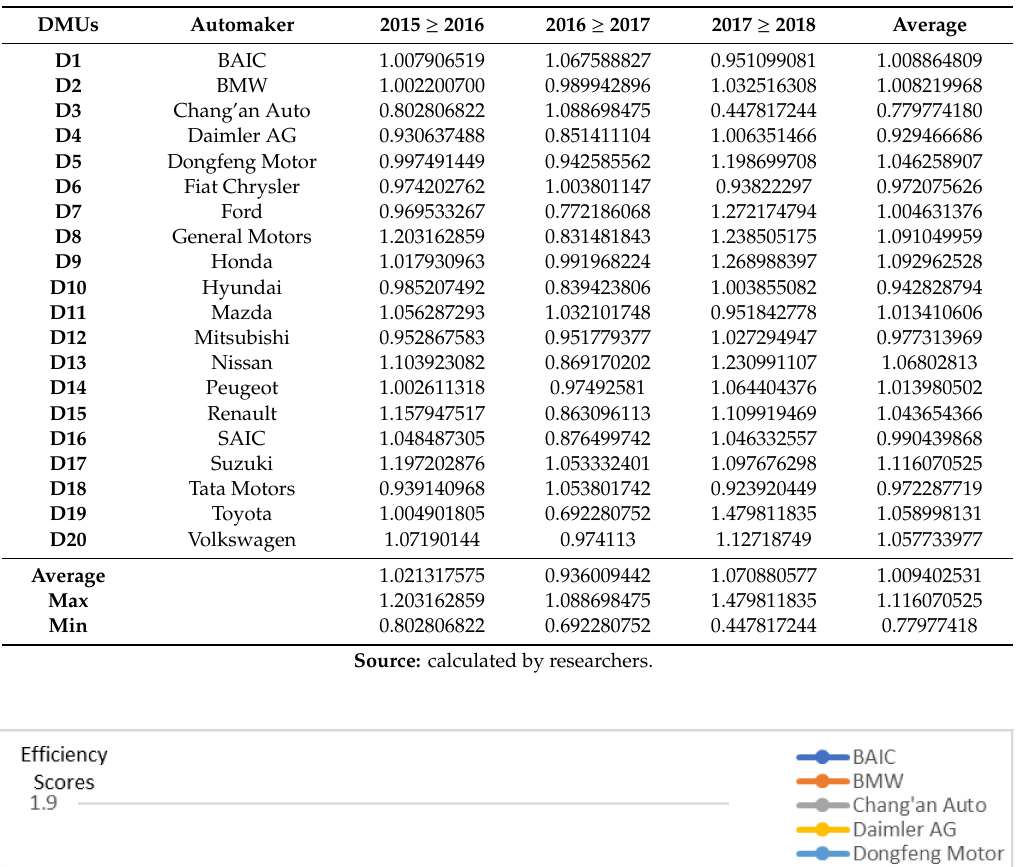
Table 4. Result of the DMUs’ catch-up index.